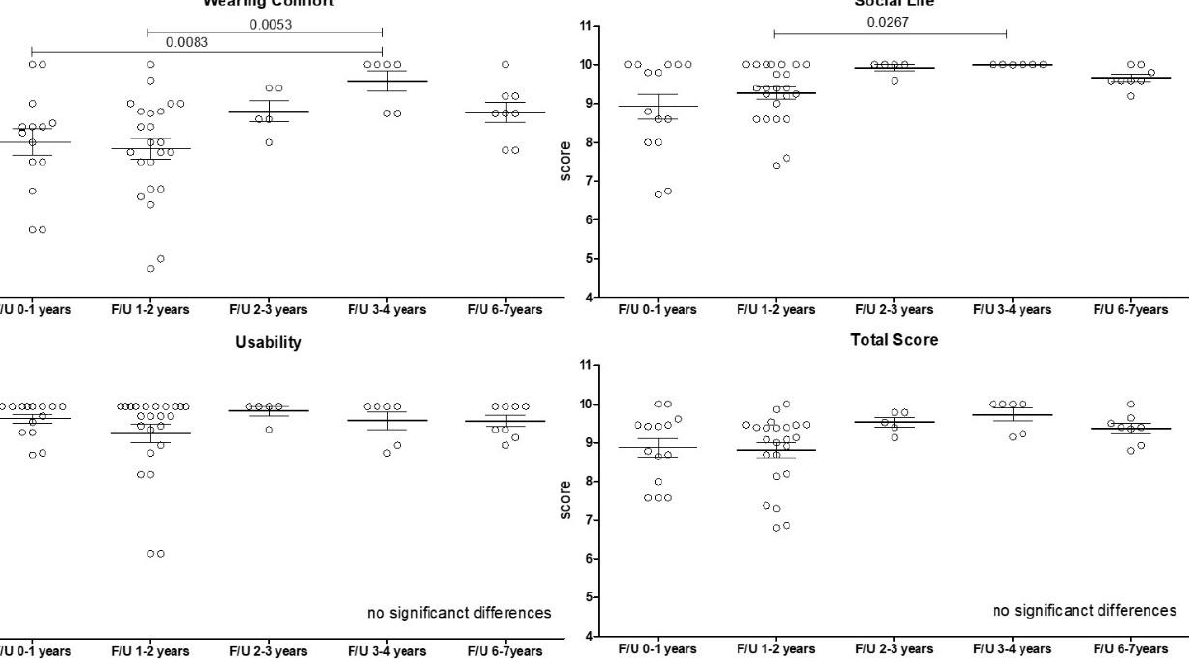
Figure 4. Audio Processor Satisfaction Questionnaire (APSQ) as a function of follow-up (F/U). Scatter boxplot showing the dimension outcomes of the Audio Processor Satisfaction Questionnaire (APSQ) over time. F/U (Follow-up).